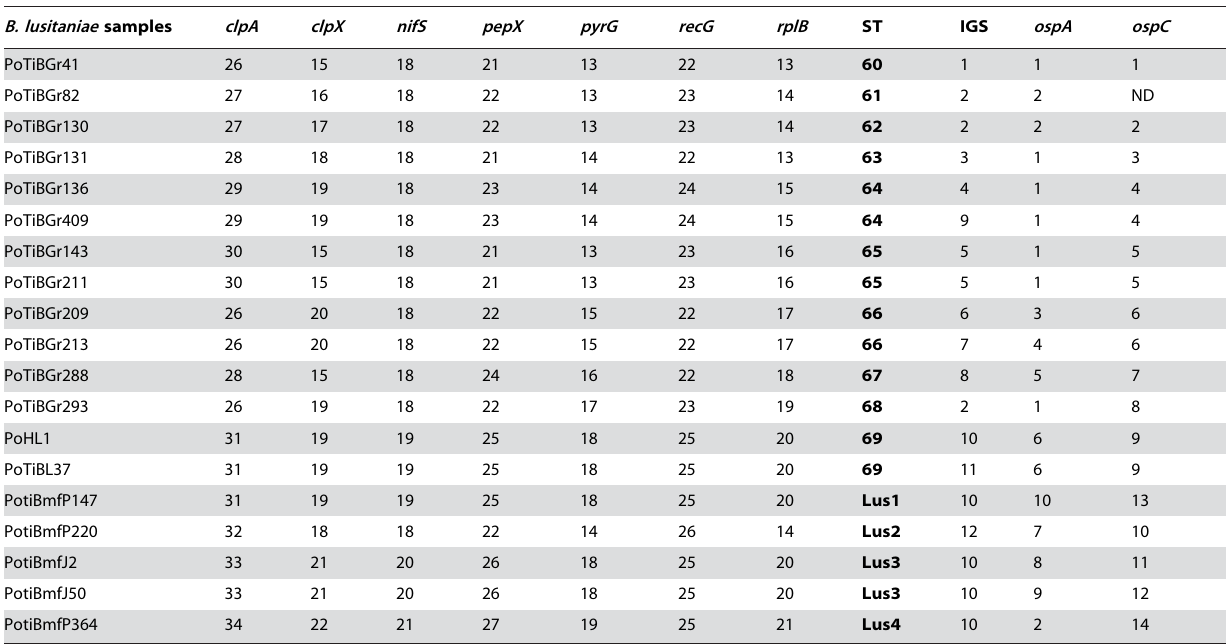
Table 2. Allelic profiles and STs of B. lusitaniae